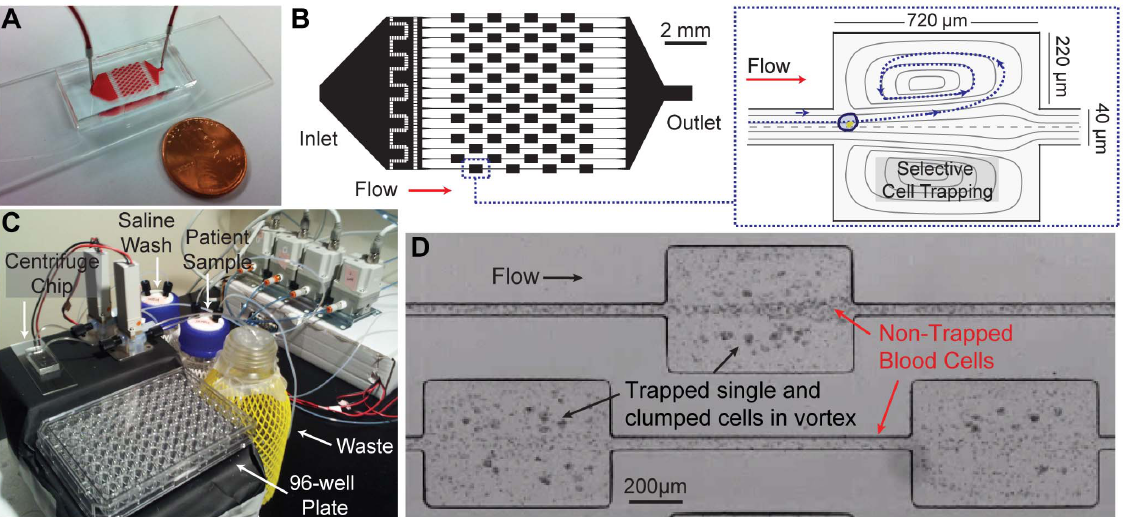
Figure 1. Principles of the Centrifuge Chip. (A) A photograph of the Centrifuge Chip device. Only a single inlet and outlet is required. (B) A schematic of the massively parallel microfluidic device that selectively traps large cells in individual microscale vortices. (C) A photograph of the device connected to an automated fluidic instrument to deliver patient pleural samples and saline wash through the Centrifuge Chip into the waste bottle or collection plate. Trapped epithelial and mesothelial cells are made readily available i) into a collection tube for further cytology slide comparisons with the original and/or ii) into a well-plate for immunolabeling, imaging and analysis. (D) High-speed microscopic image showing trapping of larger single and clumped cells while smaller red and white blood cells pass through.